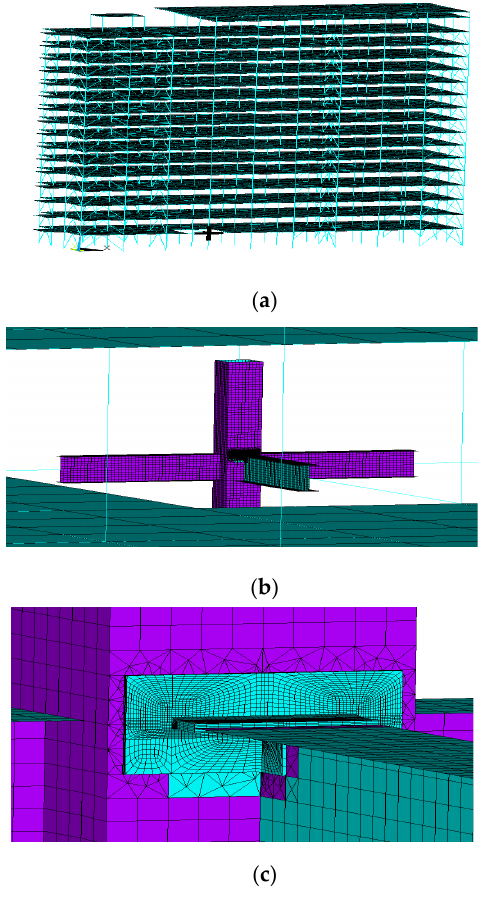
Figure 5. Multi ‐ scale element model: ( a ) global scale; ( b ) local connection scale; and ( c ) local weld scale.